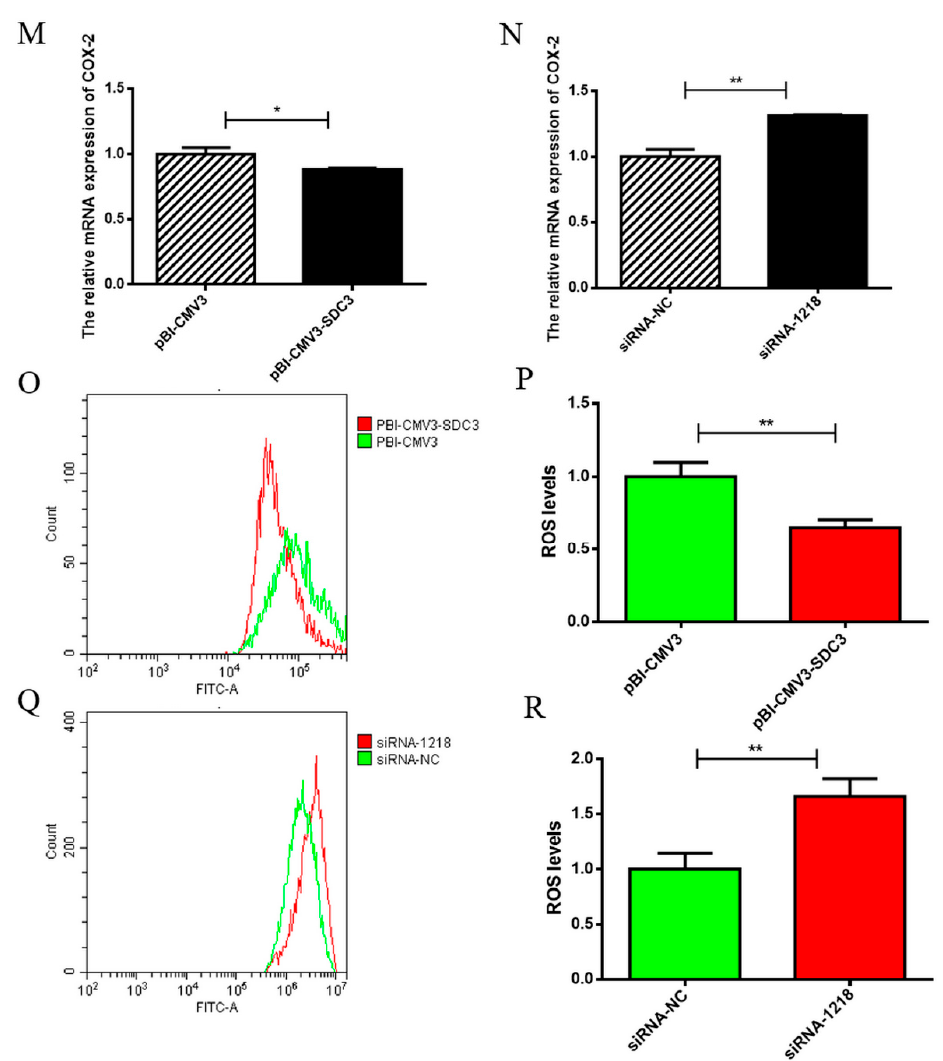
Figure 3. Effects of SDC3 on the expression of inflammatory markers in BMECs. After BMECs were treated with vectors (pBI-CMV3, pBI-CMV3-SDC3) and siRNAs (siRNA-NC, siRNA-1218) for 24 h, the transcriptional levels of IL-6, IL-1 β , TNF- α and COX-2 in BMECs were detected by RT-qPCR ( A – C , G – I , M , N ). An ELISA kit was used to measure the protein expression levels of IL-6, IL-1 β , and TNF- α in BMECs ( D – F , J – L ). The intracellular ROS level was measured using fl ow cytometry ( O , Q ), and ROS levels were analyzed ( P , R ). Data are presented as means ± SD (n = 3). Statistically signi fi - cant di ff erences are indicated: * p < 0.05, ** p < 0.01. pBI-CMV3, siRNA-NC = nonspeci fi c scrambled control.